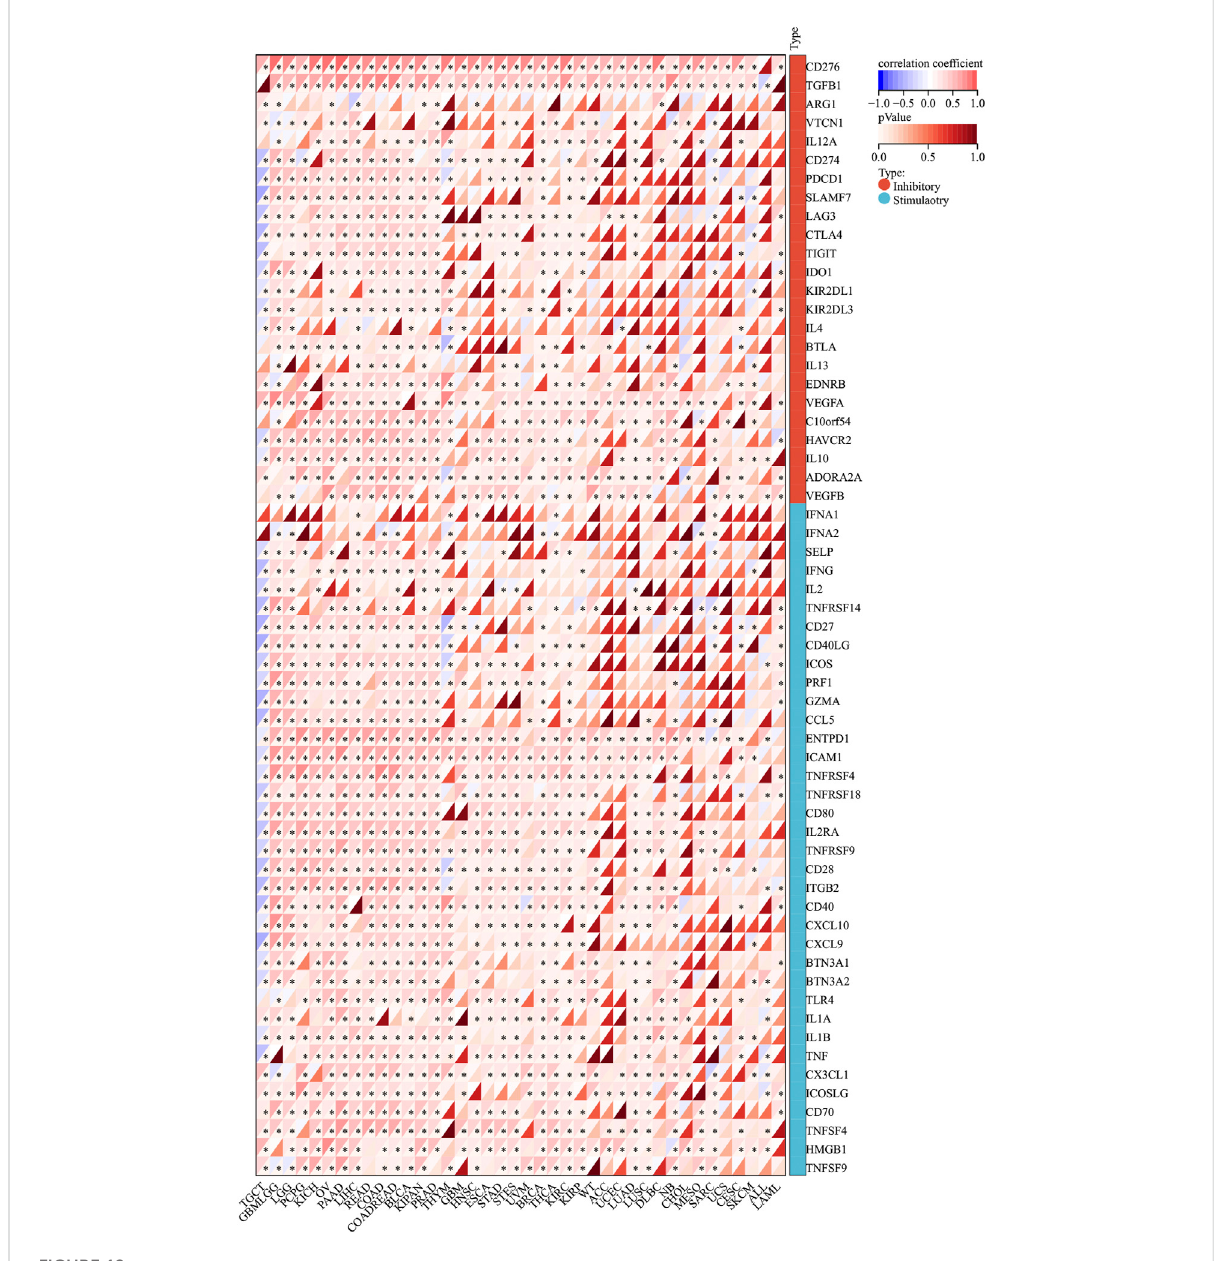
FIGURE 12 Relationship between SERPINH1 expression and pan-cancer immune checkpoint genes. * p <